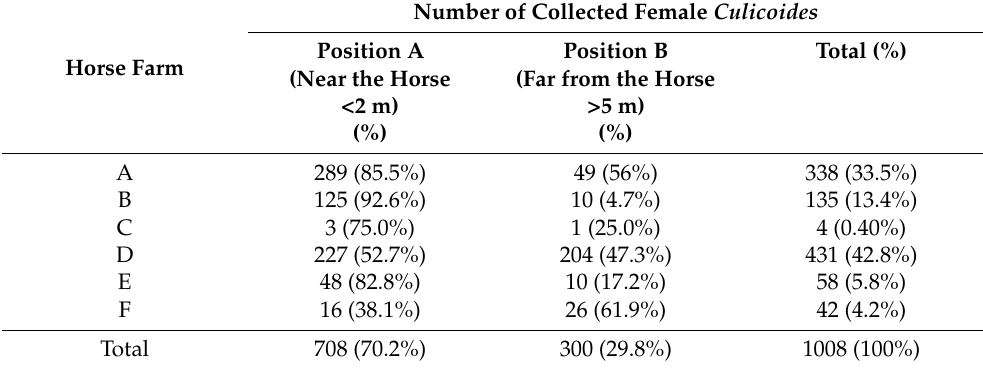
Table 1. Number of collected female Culicoides from six horse farms in Hua Hin district, Prachuab Khiri Khan Province, Thailand.